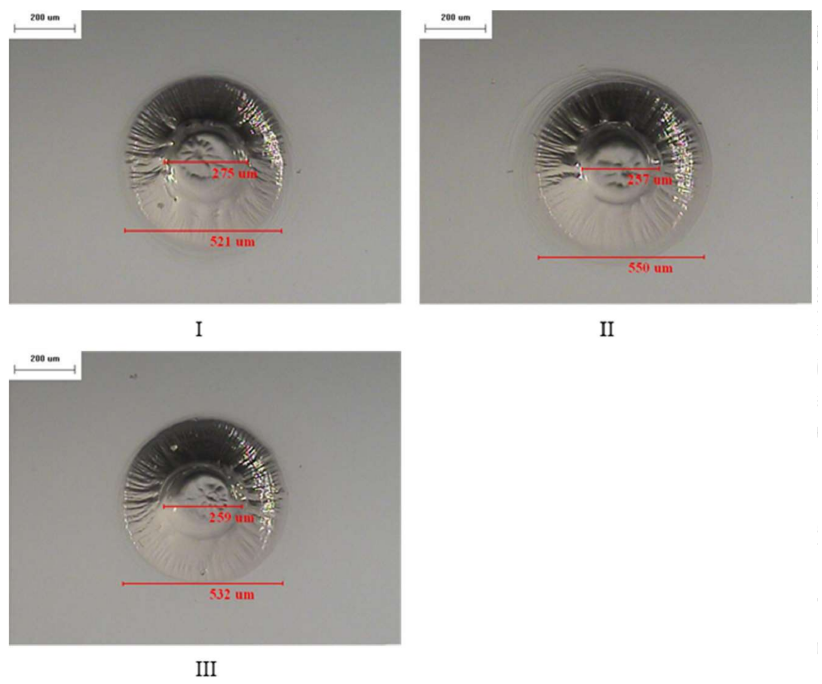
Figure 7. The diameter of the holes and the area of the thermally affected region are investigated by optical microscopy (OM) ( I – III ) 50 ×